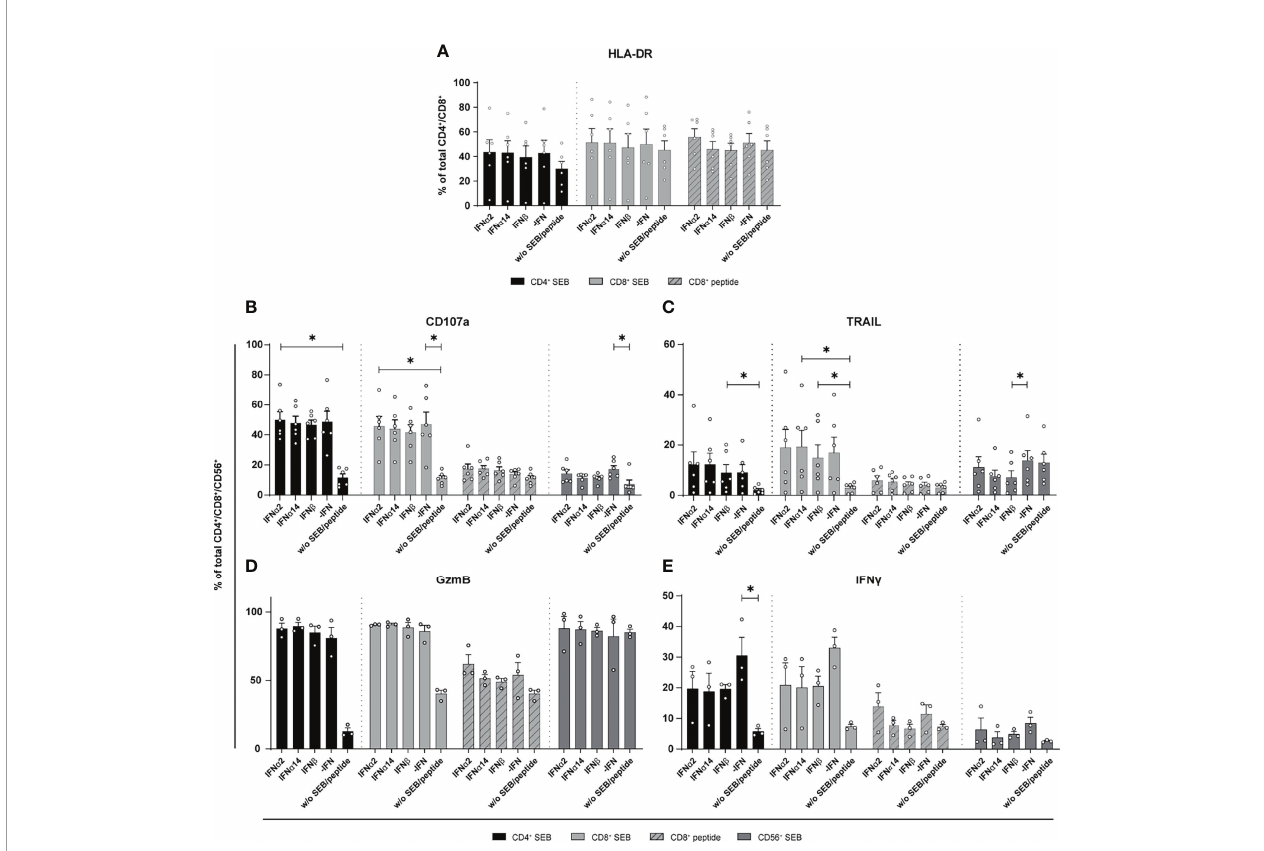
FIGURE 3 | Expression of cytotoxic molecules by in vitro stimulated T and NK cells of PBMCs from cART treated PLWH. PBMCs from cART-treated PLWH were stimulated either with 200 ng/ml SEB or with 1 µg/ml of an HLA class I restricted HIV peptide pool in presence of 2000 U/ml IFN a 2, IFN a 14, IFN b , or without IFN (-IFN) for 4 days. PBMCs were re-stimulated with 5 µg/ml SEB or 1 µg/ml peptide pool respectively and incubated in presence of antibodies against the co-stimulatory molecules CD28 and CD49d for 6 h BFA was added after 1 h of stimulation. Flow cytometry was used to analyze T cell activation and cytokine expression. (A) Activation pro fi le determined by the frequencies of HLA-DR + CD4 + and CD8 + T cells with or without stimulation in the presence or absence of the different IFNs. (B – E) Frequencies of the cytotoxic molecules CD107a, TRAIL, GzmB, and IFN g expressed on CD4 + , CD8 + T cells, and CD56 + NK cells. Mean values ± SEM are shown for (A – C) n=6 and (D, E) n=3. Statistical analyses between the treated groups within a cell population were done by using Friedman test and Dunn ’ s multiple comparison test. *, P <